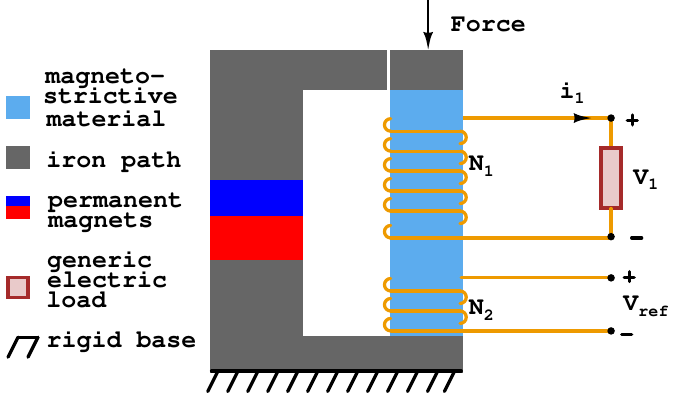
Figure 1. Sketch of the elements composing a VEH with magnetostrictive material. The iron frame and permanent magnets provide a magnetic bias, and one or more coils can be wounded around the active material. Further details about a magnetostrictive VEH can be found in [2,10,15]. PEIs play a key role in EH systems, in particular for Vibration Energy Harvesting